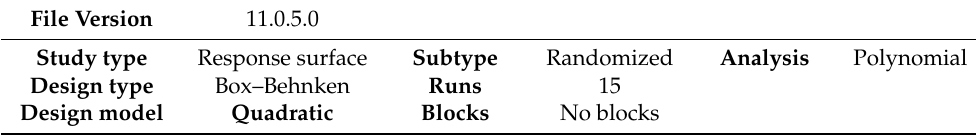
Table 5. Build information. Table 4. Design of experiment for Box–Behnken method with 15 trial runs with results of responses.